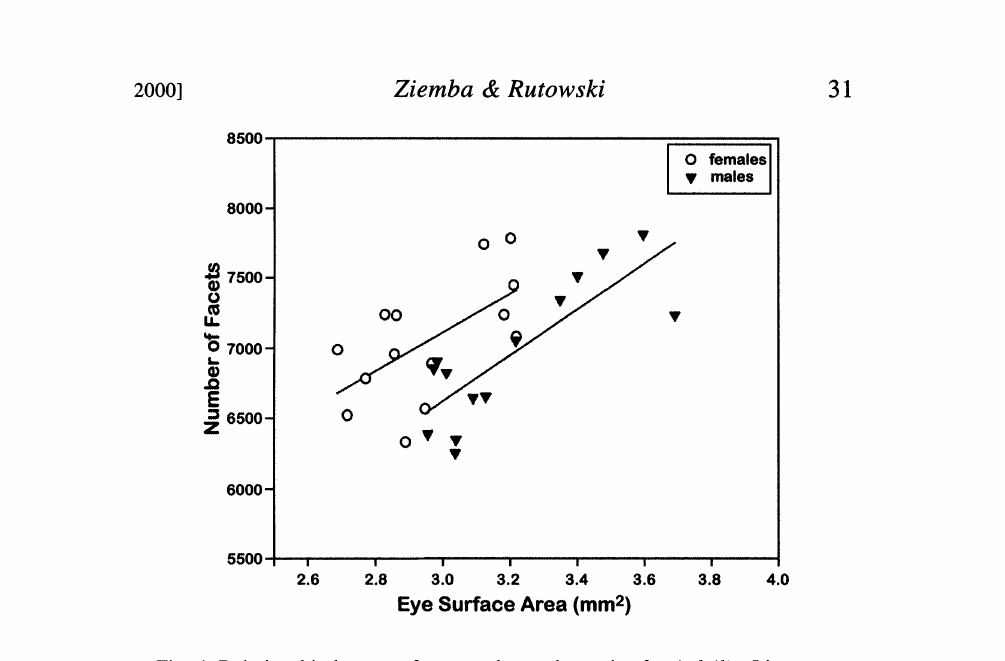
Fig. 4. Relationship between facet number and eye size for A. leilia. Lines repre- sent least squares linear regression for males (’) and females (O).